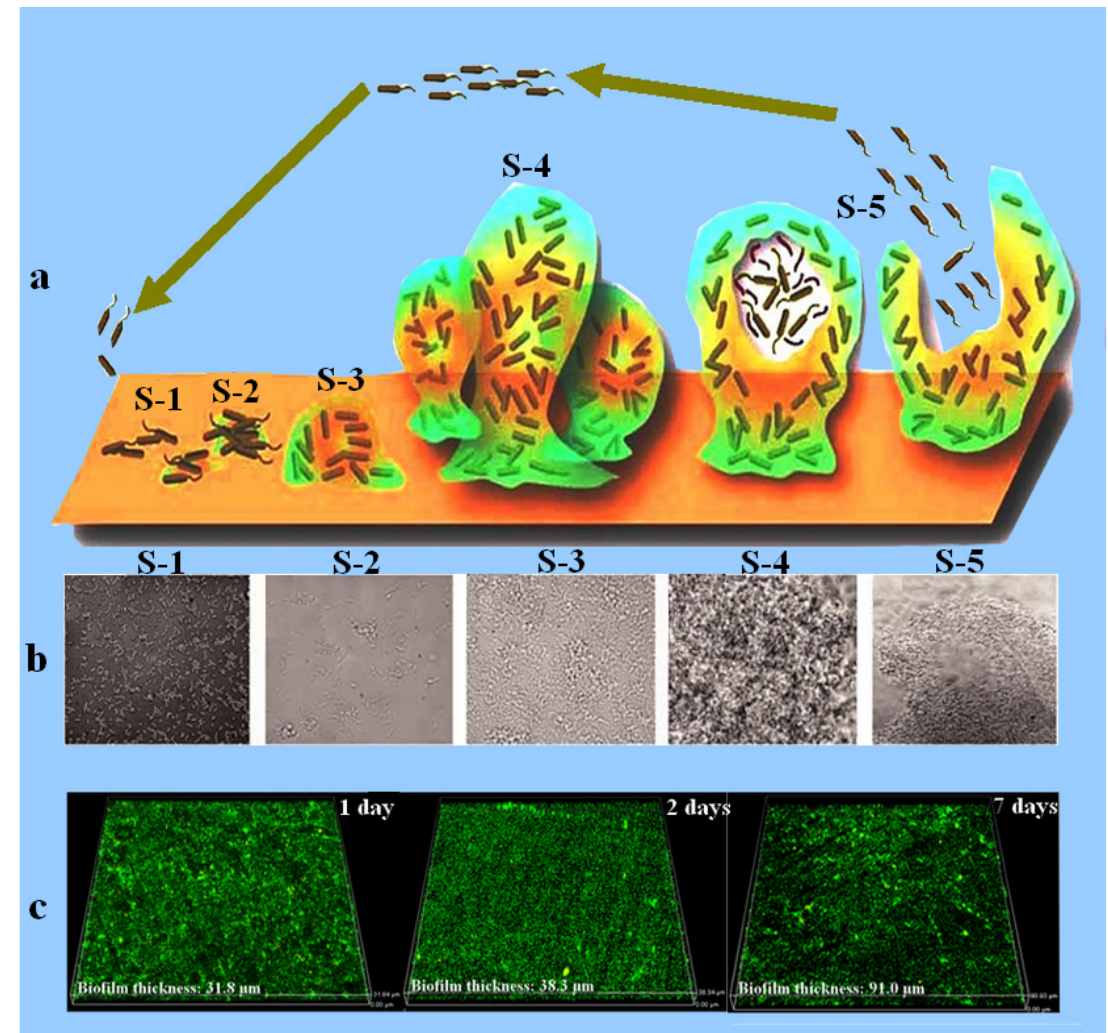
Figure 2. Schematic diagram showing different stages (S ‐ 1 to S ‐ 5) of biofilm development ( a ) [34]. Each stage of the biofilm development is also shown by the SEM images ( b ), where S ‐ 1 represents the initial stage of bacterial cells attachment to the surface, S ‐ 2 is the second stage which represents the colonization of bacterial cells and EPS secretion, S ‐ 3 represents the initial stage of biofilm formation, S ‐ 4 represents the well ‐ developed biofilm, and S ‐ 5 is the last stage in which the bacterial cells are releasing from the biofilm and are ready to attach a new surface. Reprinted with permission from ref. [34,35]. Copyright 2022 Frontiers in chemistry. ( c ) represents the CLSM images showing the biofilm thickness measured after 1, 2, and 7 days of immersion in a medium inoculated with marine bacteria Marinobacter aquaeolei .